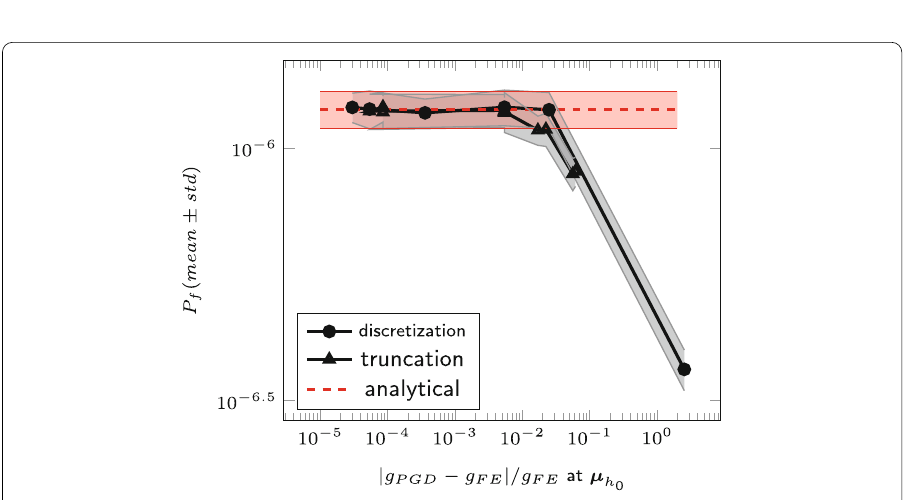
Fig. 9 1D truss: convergence of failure probability (left) and its standard deviation (right) over the number of samples N running itPGDrel-PF for it = 1 (50 runs, p 0 = 0 . 1, N p = 100, N max = 25 , 600 and ξ = 10)